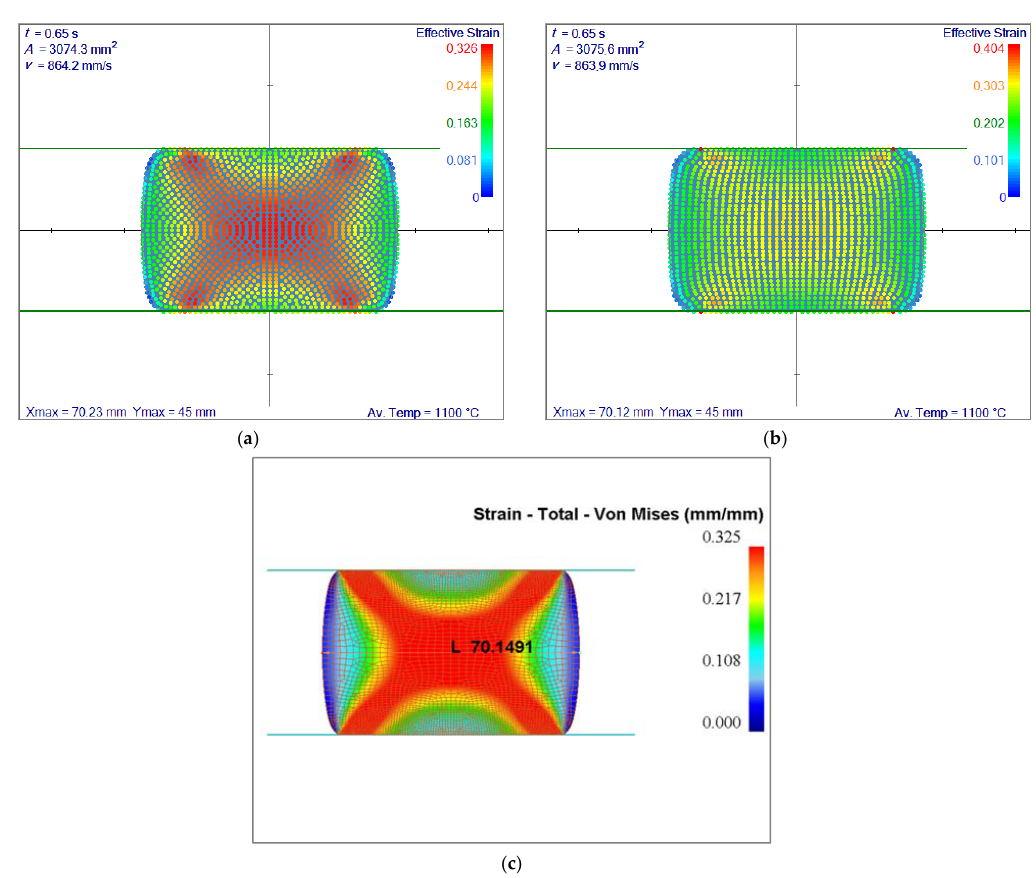
Figure 9. Comparison of simulated effective strain fields. Irregular nodes ( a ), regular nodes with mapping ( b ) and FEM results ( c ). The results of all three simulations are practically the same: ( a ) 70.23 mm, ( b ) 70.12 mm, ( c ) 70.15 mm. Av. Temp. stands for average temperature.